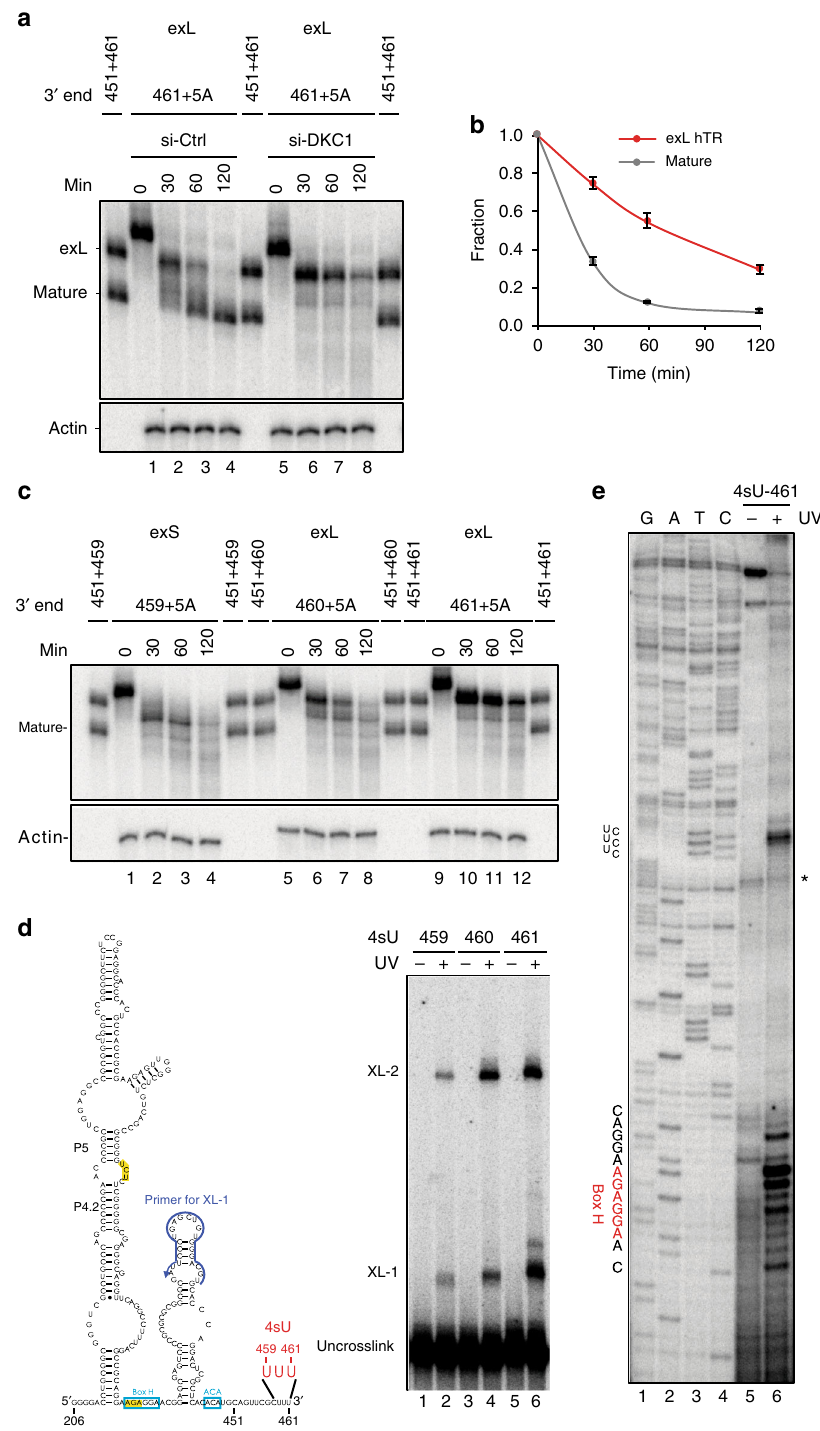
Fig. 4 A triplet helix structure forms in exL. a The 32 P-labeled in vitro transcribed hTR fragments were incubated in extracts prepared from 293T cells subjected to dyskerin knockdown and control siRNA for the indicated times. RNA was puri fi ed and resolved by a 6% polyacrylamide/8 M urea gel. b The 32 P-labeled in vitro transcribed hTR fragments were incubated in dyskerin knockdown extracts for the indicated times. RNA was puri fi ed and resolved on a 6% polyacrylamide/8 M urea gel. The hTR signal was quanti fi ed using a phosphoimager. The ratio of each RNA species was normalized to both time 0 and the loading control, Actin. Mean values were calculated from three biological replicate experiments as shown in Supplementary Figure 6. Bars represent the standard error. For the mature form, 50% is degraded after 22.4 min, for exL after 69.9 min. c The 32 P-labeled in vitro transcribed hTR fragments were incubated in dyskerin knockdown extracts for the indicated times. RNA was puri fi ed and resolved on a 6% polyacrylamide/8 M urea gel. d Schematic showing an hTR fragment with a single nucleotide replaced with 4-thiouridine (4sU) for positions 459, 460, and 461 used for the in vitro UV crosslinking assay. Nucleotides modi fi ed with 4sU are shown in red. The primers used for primer extension are shown in blue. RNA crosslinks were induced by irradiation with UV light. The crosslinked products were resolved on a 6% polyacrylamide/8 M urea gel. e Speci fi c signals corresponding to XL-1 were gel- puri fi ed and mapped by primer extension. Asterisks mark non-speci fi c RT pause